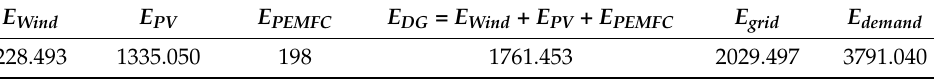
Table 5. The DG and energy demands (kWh).